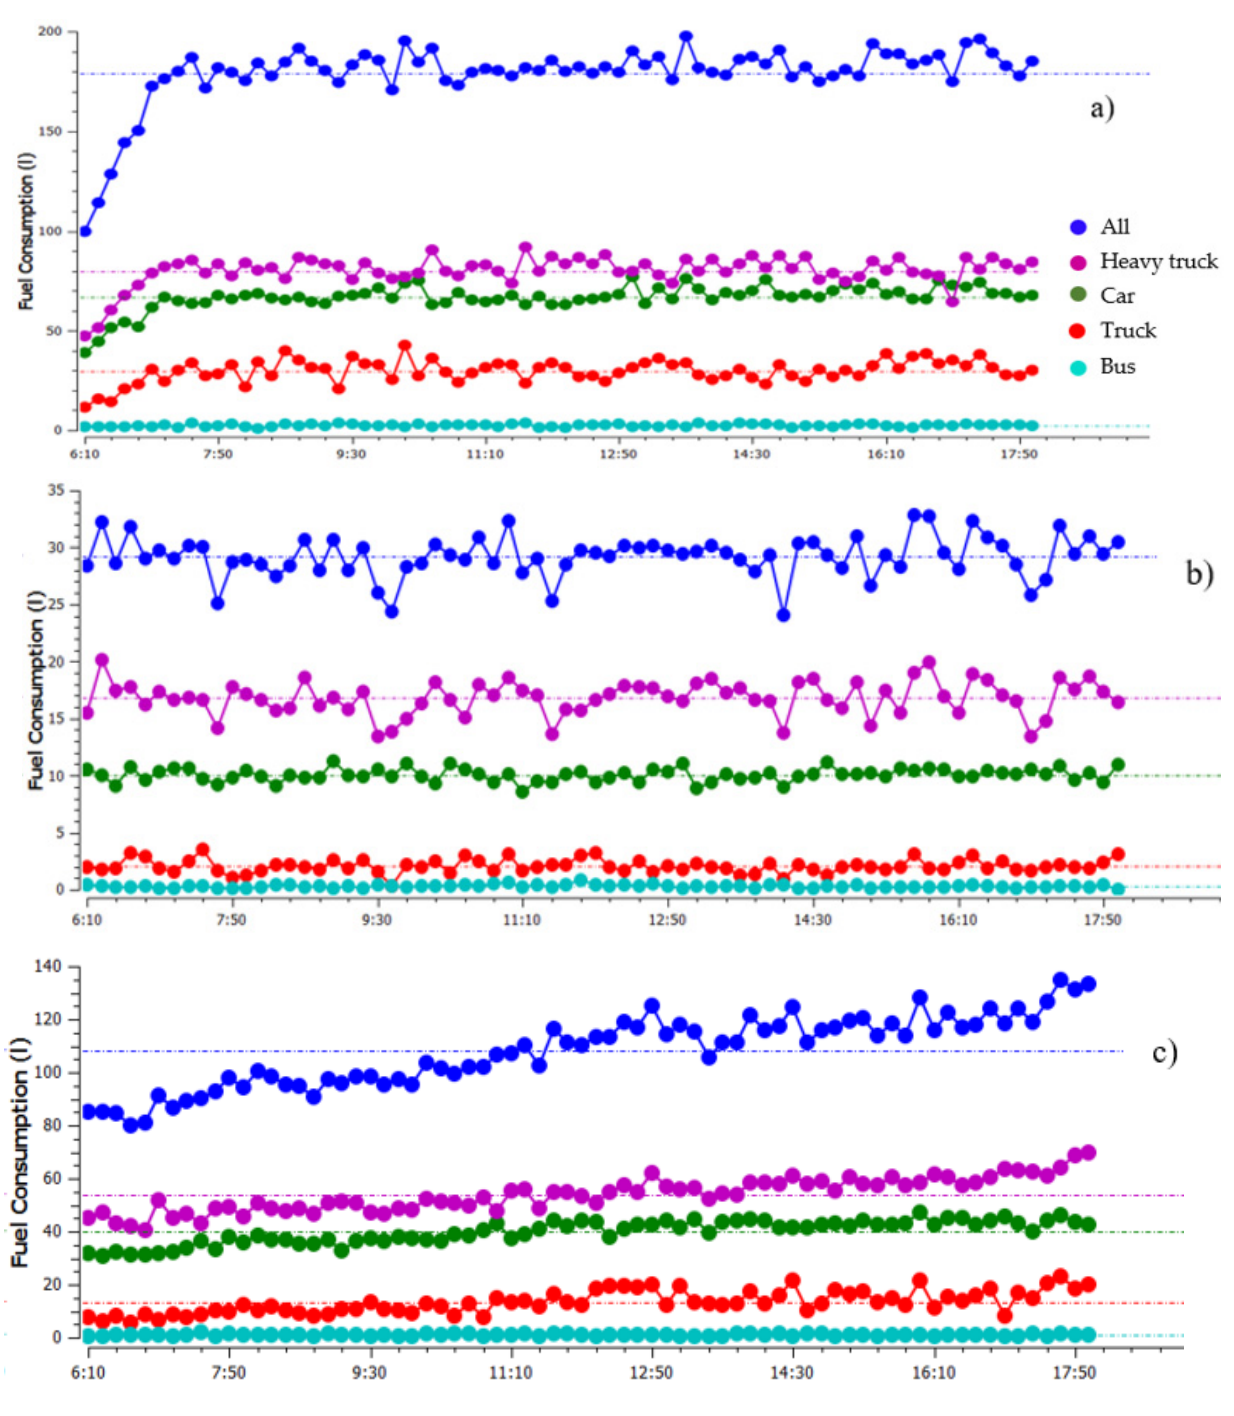
Figure 8. Course of fuel consumption for individual vehicle categories in 2019 ( a ), 2020 ( b ), and 2021 ( c ).